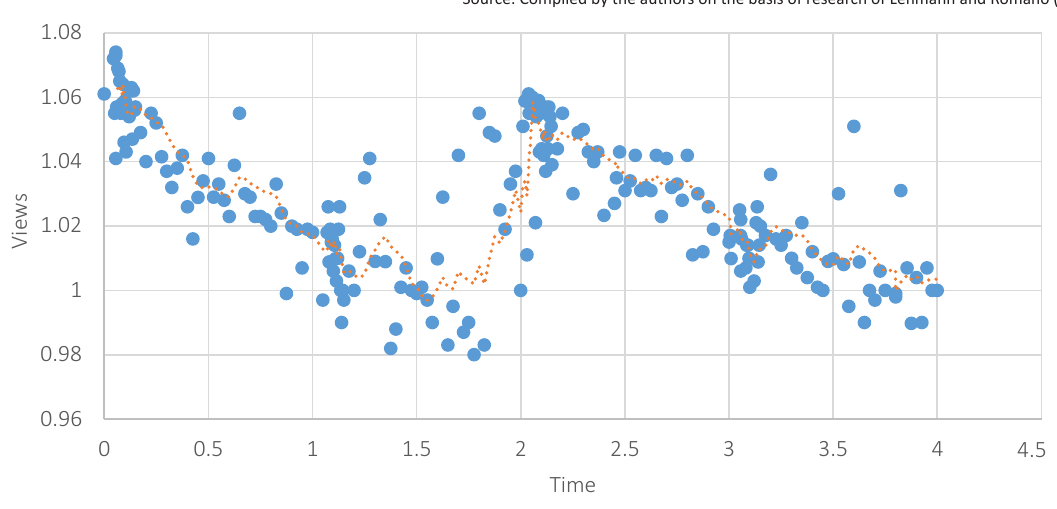
Figure 14. Approximation of time series of advertising reviews (dotted lines) in the system of successive advertising: In-Stream та TrueView Video Discovery (In-Display) (the OX axis is time, and on the OY axis –